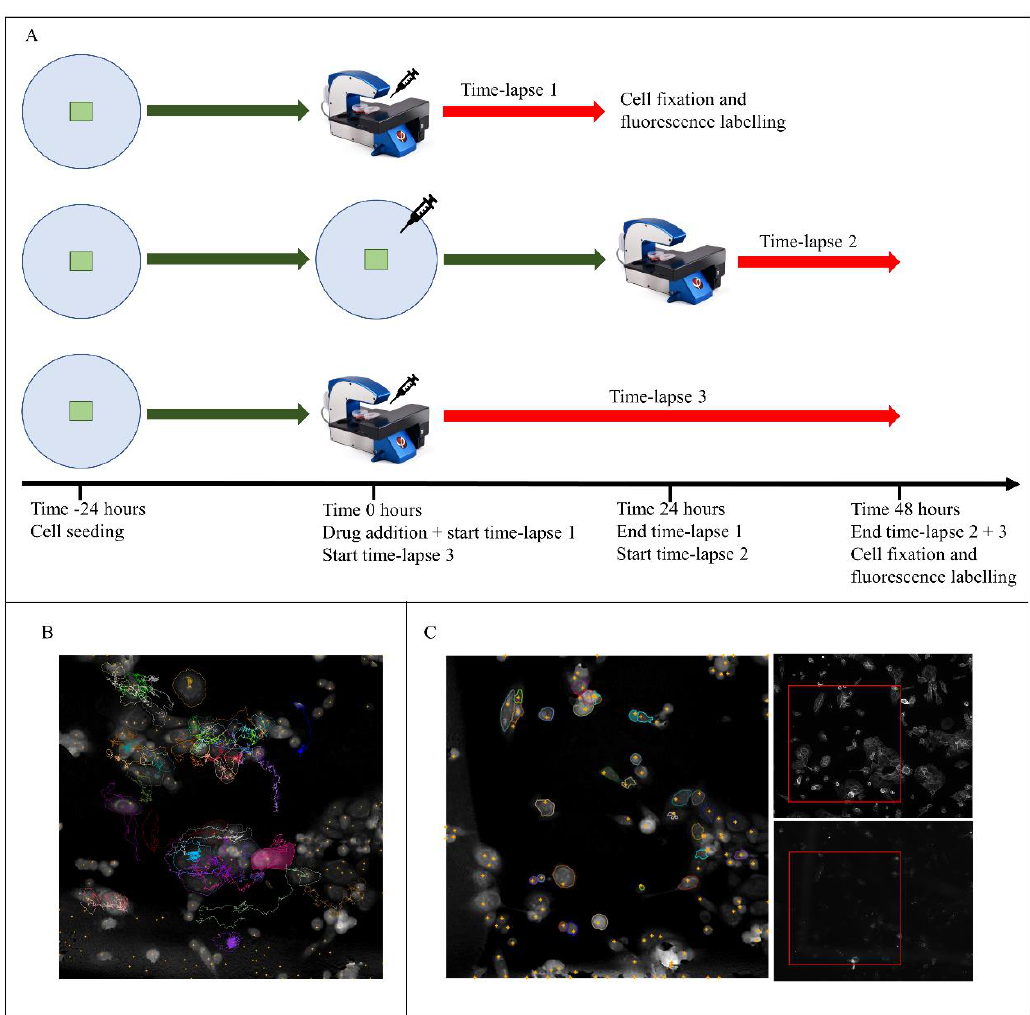
Figure 1. Schematic view of the experimental set-up. ( A ) Before seeding, an area was marked on the outside of the bottom part of Petri dishes. At time -24 h, cells were seeded in multiple Petri dishes. ( ). Salinomycin was added to a final concentration of 0.5 µM 24 h after seeding ( ). The cells inside the marked area were imaged by digital holography for 24-h or 48-h periods ( , Time-lapse 3), with the start of the time-lapses immediately after treatment ( , Time-lapse 1) or 24 h after treatment ( , Time-lapse 2). After the time-lapse, the cells were fixed and labeled with FITC-conjugated anti-CD44 antibodies and PE-conjugated anti-CD24-antibodies or labeled with Alexa Flour 488-labeled anti-E-cadherin and PE-conjugated anti-CD24-antibodies and then imaged in a fluorescence microscope. ( B ) Representative image of cells tracked through a time-lapse of digital holographic images. The colored trails show cell movement during the time-lapse. The tracking is the basis for all longitudinal analysis. ( C ) Representative images used for visual over-lay, which allowed for cell identification in the time-lapse. Left image: digital holography. Upper right image: fluorescence, CD44 staining. Lower right image: fluorescence, CD24 staining. The red box corresponds to the area image by digital holography. The time-lapse images were captured within the marked square using a stitching pattern as shown in Figure 1A. Sixteen images were captured for each square to cover the entire area. Images were captured every 15 min. Thus, for each square, 16 time-lapses were captured with images every 15 min. The experiment was repeated three times with two time-lapses analyzed for each dish, i.e., each figure includes six time-lapses per treatment and time interval. At the end of the time-lapses, the cells were fixed in 4% formaldehyde and labeled as described below to allow identification based on CD24, CD44, and E-cadherin